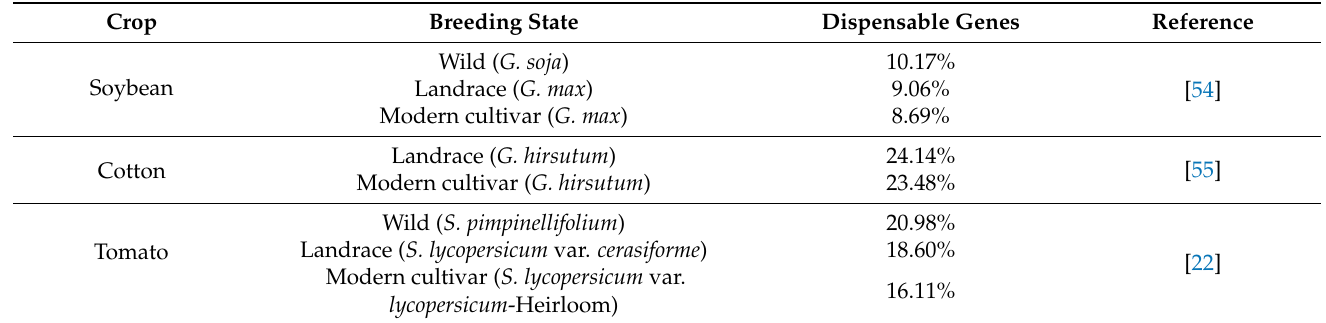
Table 1. Content of dispensable genes derived from selected pangenomes for soybean, cotton and tomato evaluated across different breeding